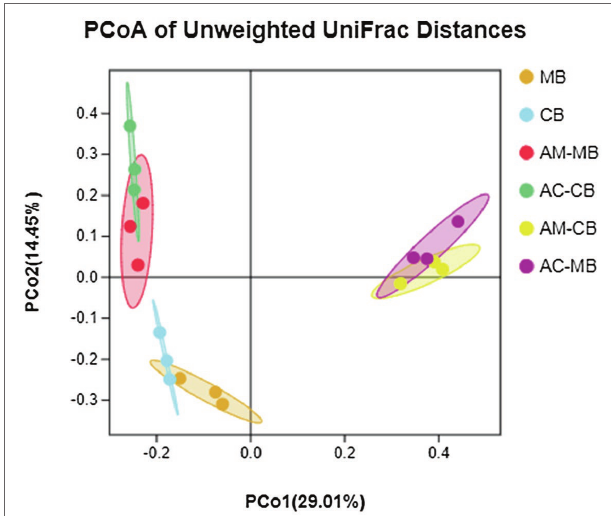
FIGURE 3 | Principal coordinate analysis (PCoA) of unweighted UniFrac distances for all samples of the bee bread and midgut of Apis mellifera